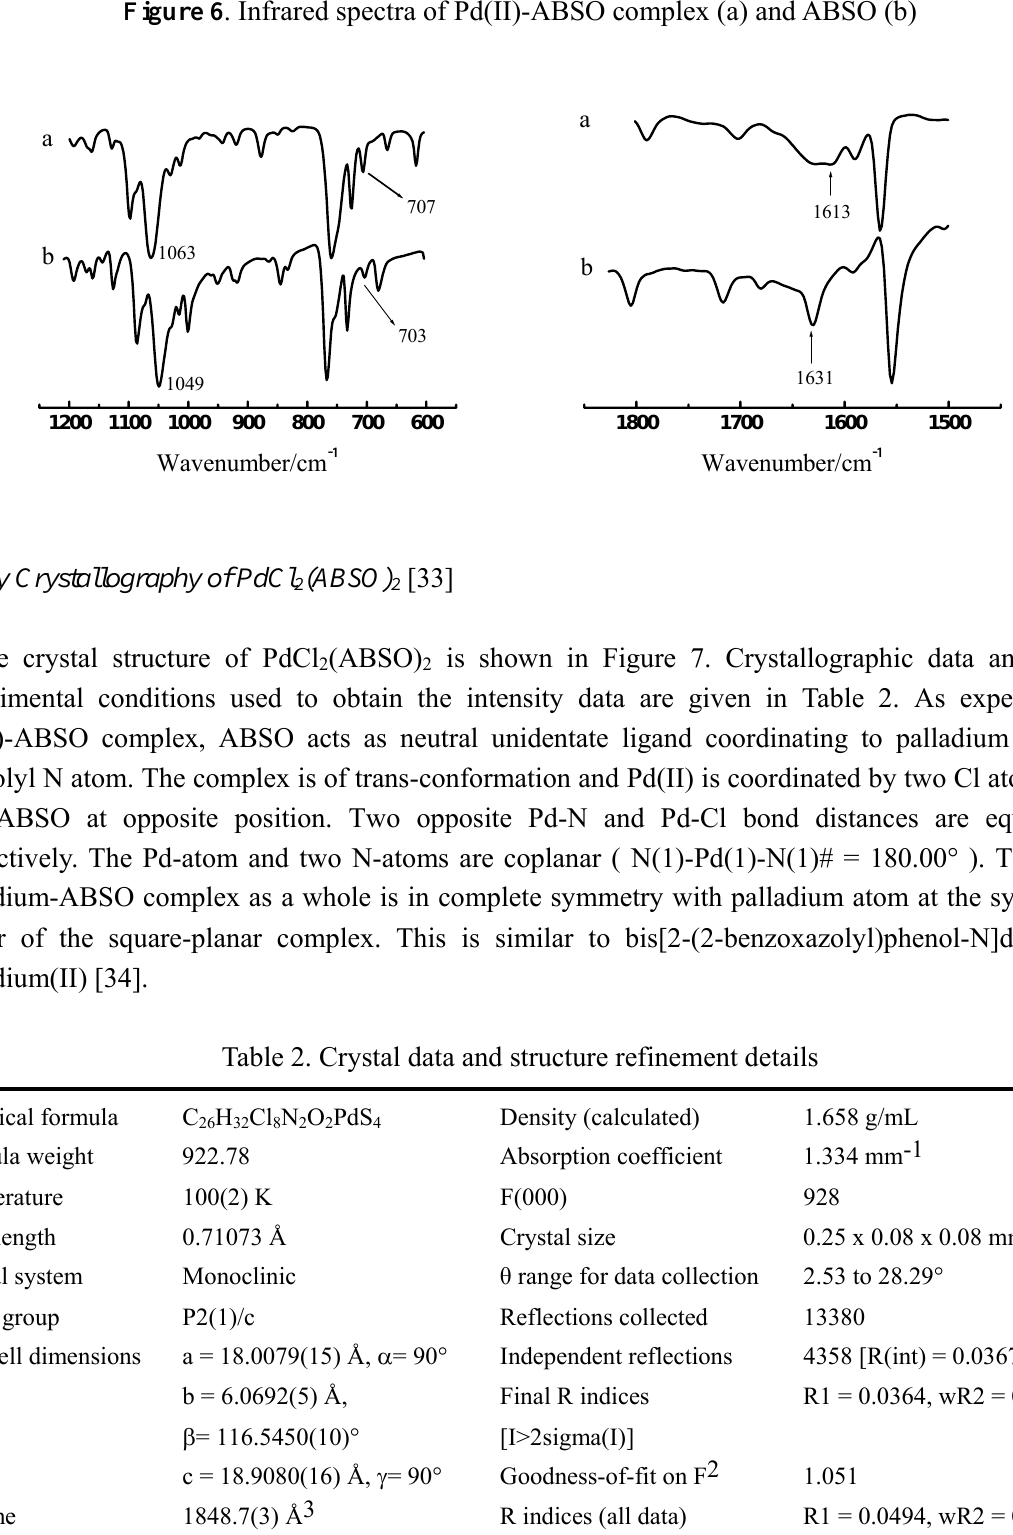
Figure 6 . Infrared spectra of Pd(II)-ABSO complex (a) and ABSO (b)